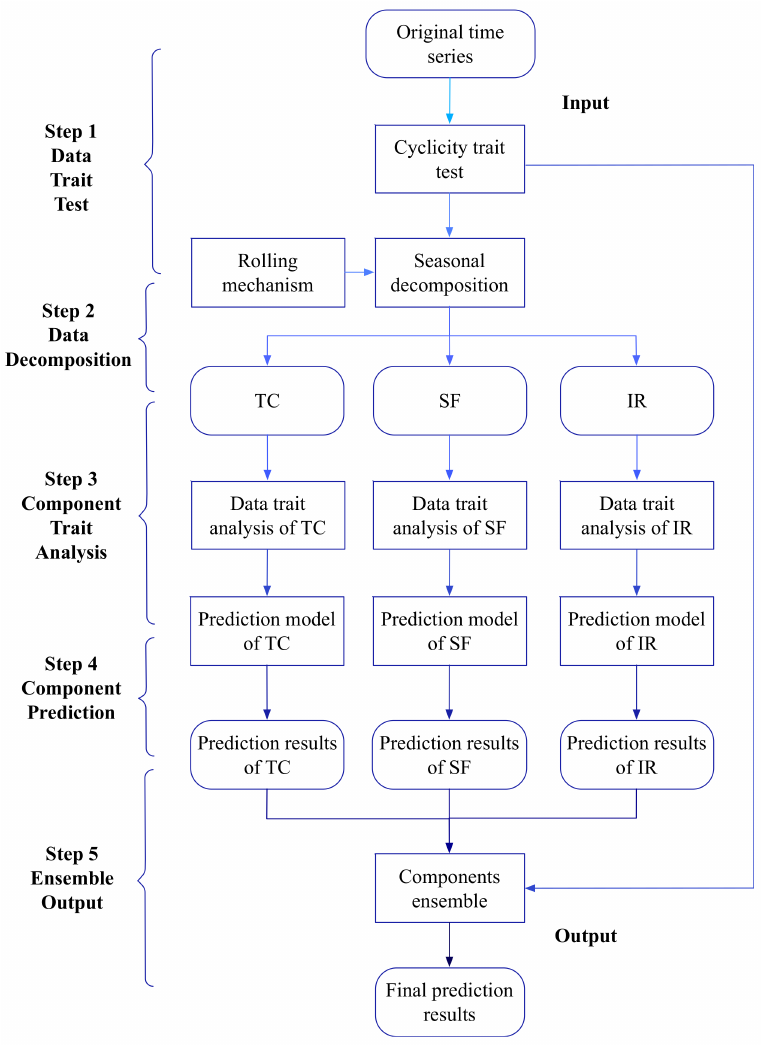
Figure 1. General framework of the proposed data-trait-driven rolling decomposition-ensemble learning